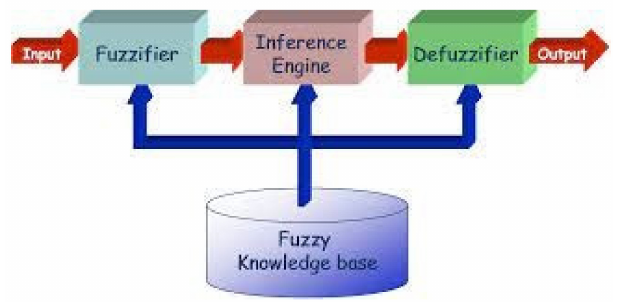
Figure 4. Fuzzy logic